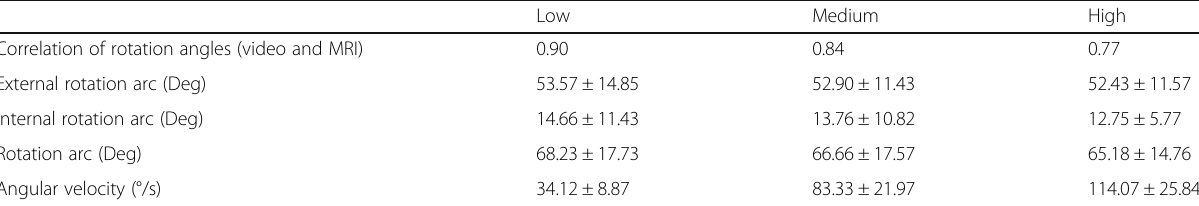
Table 1 Parameters of active shoulder rotation at three motion